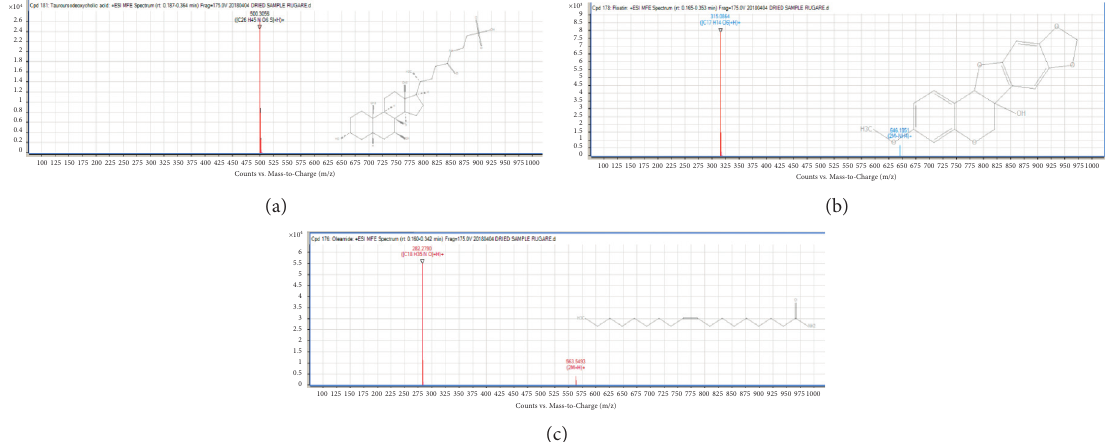
Figure 4: Cumulative LC-MS spectra for (a) tauroursdeoxycholic acid, (b) pisatin, and (c) anhalonidine that were detected in sorghum variety SC Macia